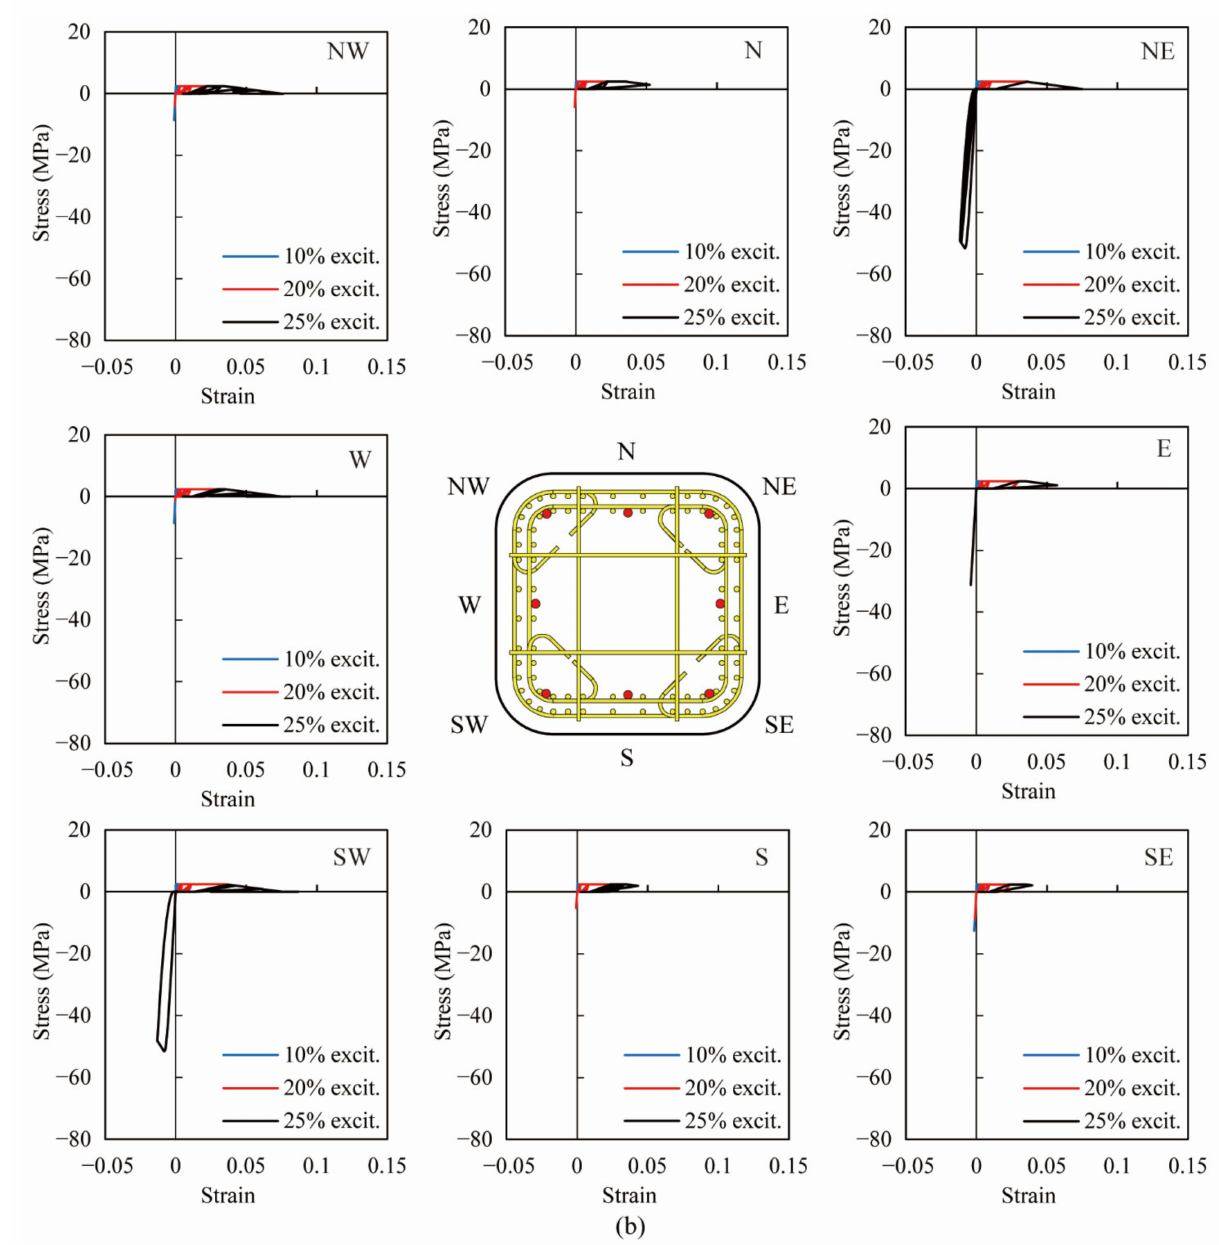
Figure 13. Analytical stress-strain hysteresis of extreme fibers in core at the column base in eight directions. ( a ) PFRC-1, ( b )